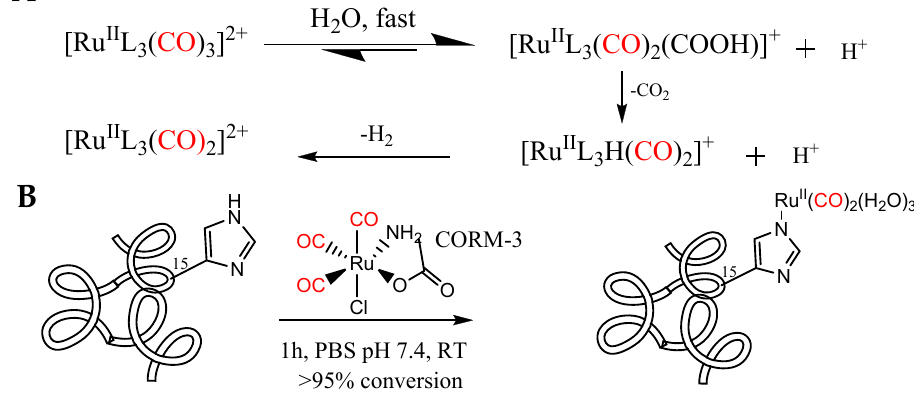
Figure 14. The reactivity of the fac -[RuL 3 (CO) 3 ] 2 + complex ( A ) and CORM-3 react with single-His protein ( B ).